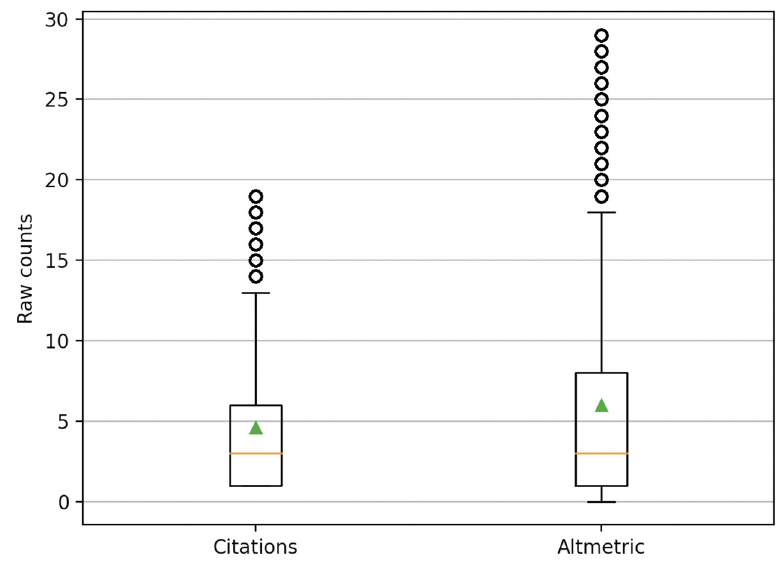
Figure A14. Humanities and social sciences research papers from Dimensions (2015–2022): average total citations and Altmetric scores.